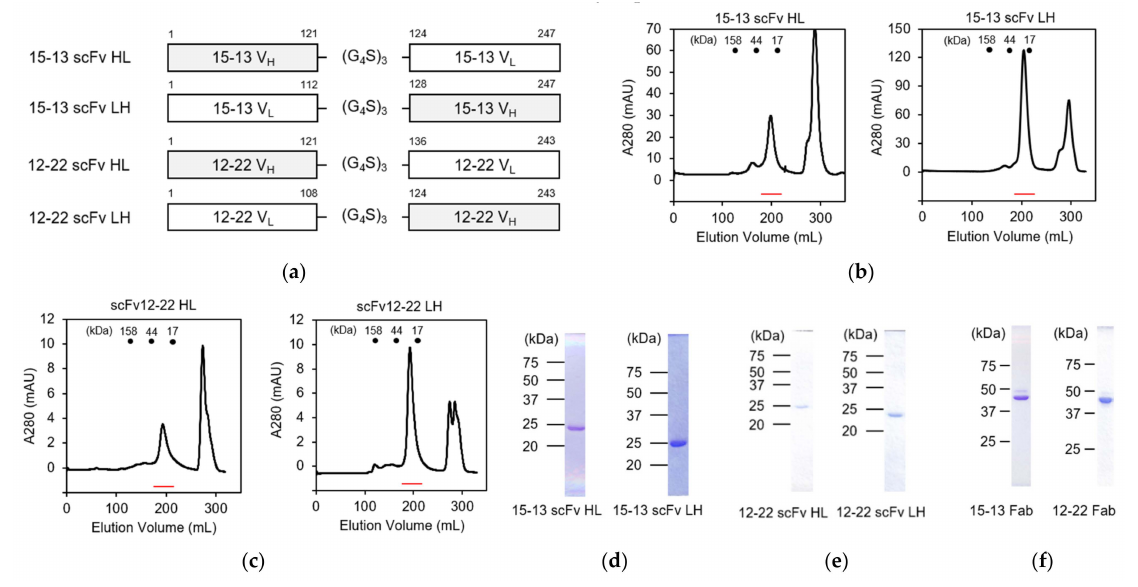
Figure 2. Construction and purification of anti-RABVG antibodies. ( a ) Schematic structures of 15–13 scFv HL and LH, and 12–22 scFv HL and LH; ( b , c ) The size exclusion chromatogram of refolded 15–13 scFv HL and LH ( b ), and 12–22 scFv HL and LH ( c ). Red lines represent the elution positions of scFvs; ( d , e ) SDS-PAGE of purified 15–13 scFv HL and LH ( d ), and 12–22 scFv HL and LH ( e ), under nonreducing conditions. ( f ) SDS-PAGE of purified 15–13 Fab and 12–22 Fab under nonreducing conditions. Table 3. Expression and preparation efficiency of each scFvs. Inclusion body and final yields from 1L of culture medium are